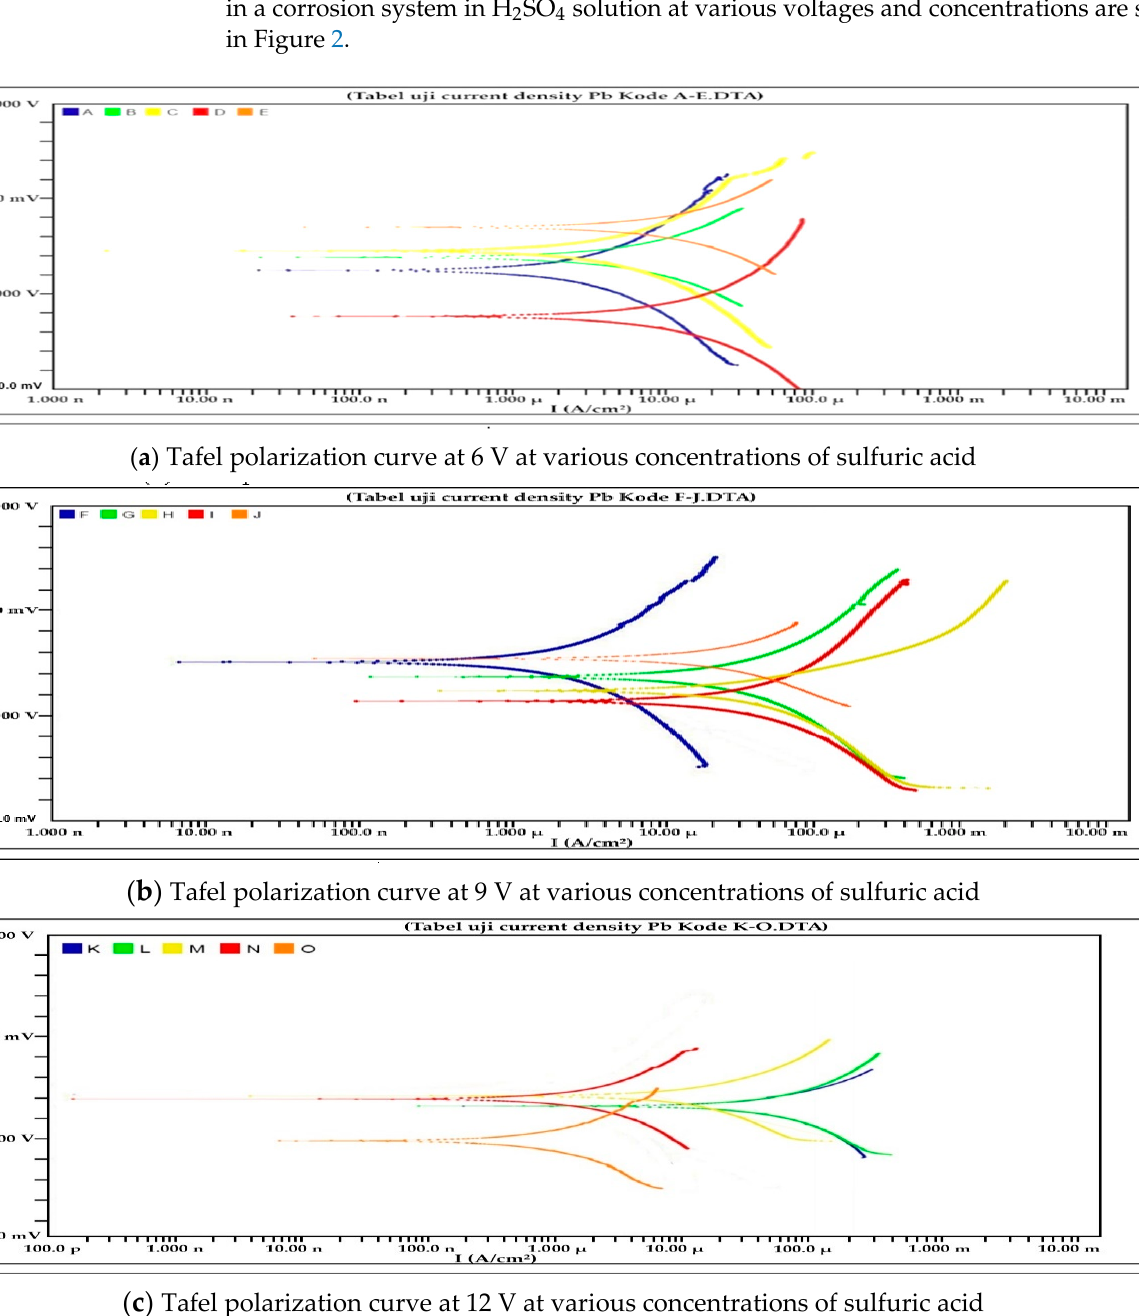
Figure 2. Tafel polarization curves at a voltage of ( a ) 6 V, ( b ) 9 V, and ( c ) 12 V at various concentrations of sulfuric